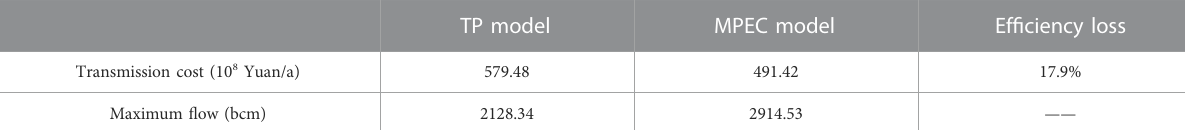
TABLE 1 Transmission ef fi ciency of China ’ s natural gas